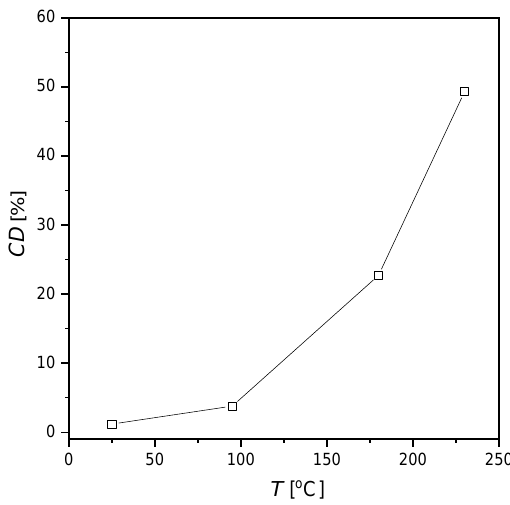
Figure 6. Corrosion degree ( CD ) for the AISI 1010 steel electrodes immersed in sulfolane at 25, 95, 180, and 230 ◦ C.